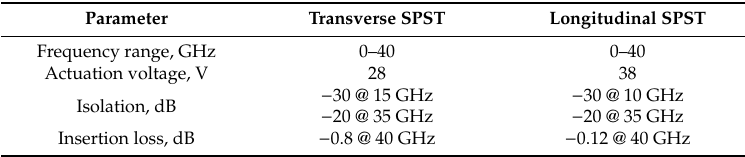
Table 1. Main simulated radio frequency (RF) characteristics for the transverse and longitudinal Single Pole Single Throw (SPST) RF-MEMS switches previously shown in Figure